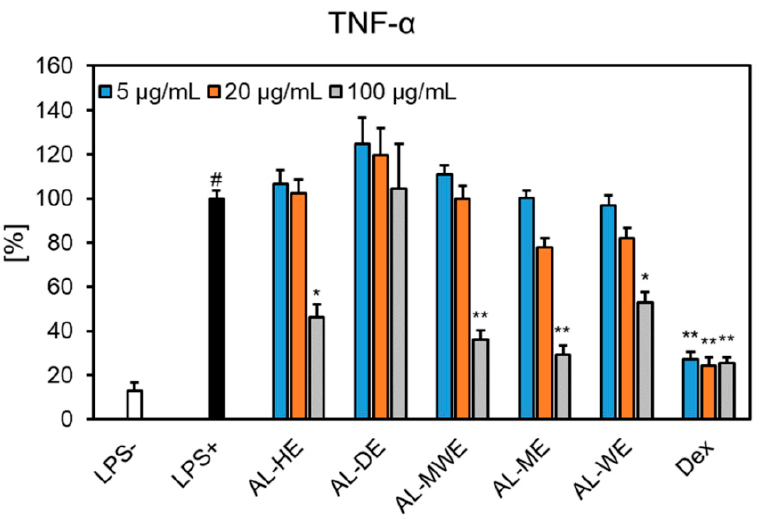
Figure 9. The effects of Artemisia campestris subsp. lednicensis extracts (5–100 μ g/mL) and dexame-